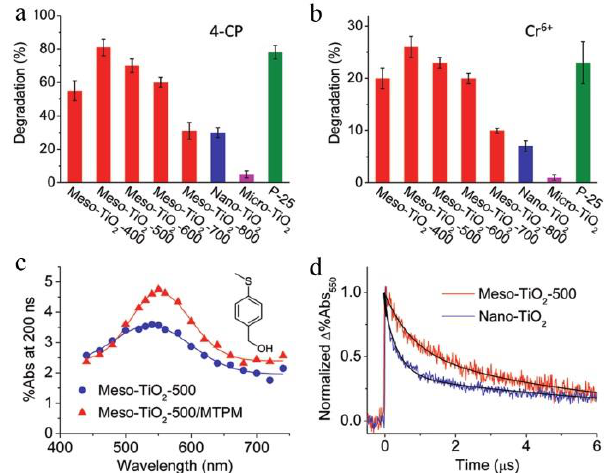
Figure 15. Photodegradation of ( a ) 4-CP and ( b ) Cr(VI) using various kinds of TiO 2 as catalysts. ( c ) Time-resolved diffuse reflectance spectra observed at 200 ns after the laser flash (355-nm) during the photolysis of Meso-TiO 2 -500 in the absence and presence of 10 mM 4-(methylthio) phenyl methanol (MTPM) as the probe molecule to estimate the lifetime of the charge-separated state in acetonitrile. ( d ) Differential time traces of %Abs at 550 nm obtained in the presence of 10 mM MTPM for different TiO 2 samples in acetonitrile. Reprinted with permission from [135]. Copyright American Chemical Society, 2012.